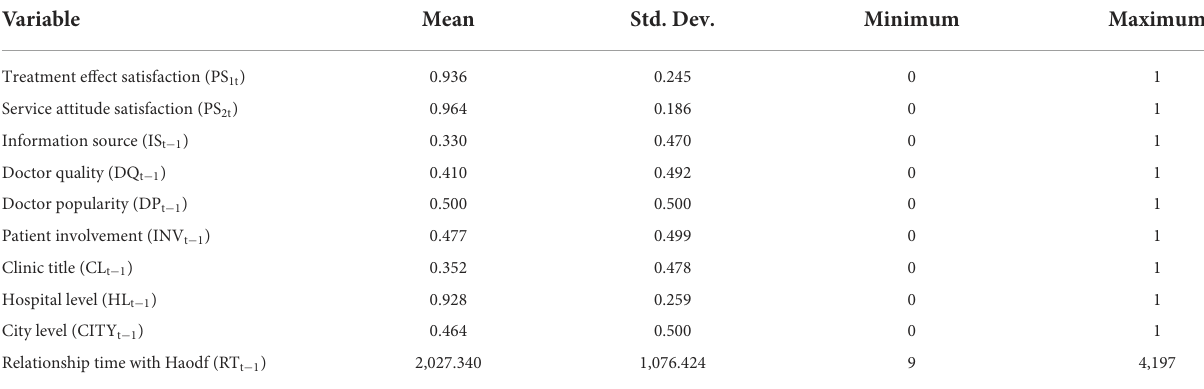
TABLE 2 Descriptive statistics of variables.